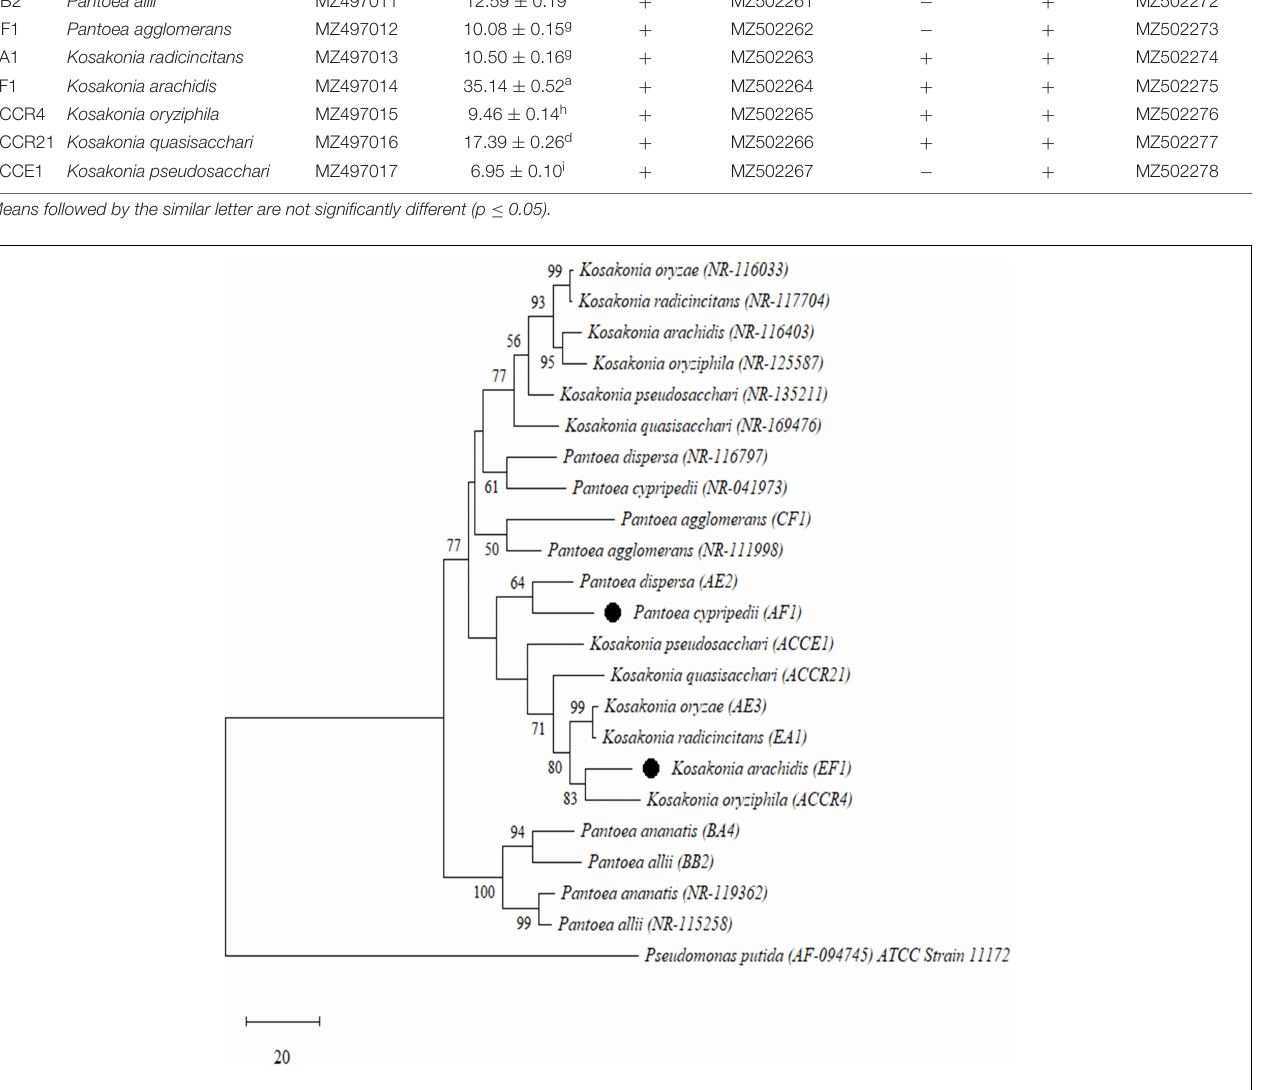
K. arachidis , ACCR4- K. oryziphila , ACCE1- K. pseudosacchari, and ACCR21- Kosakonia quasisacchari ) as shown in Figure 1